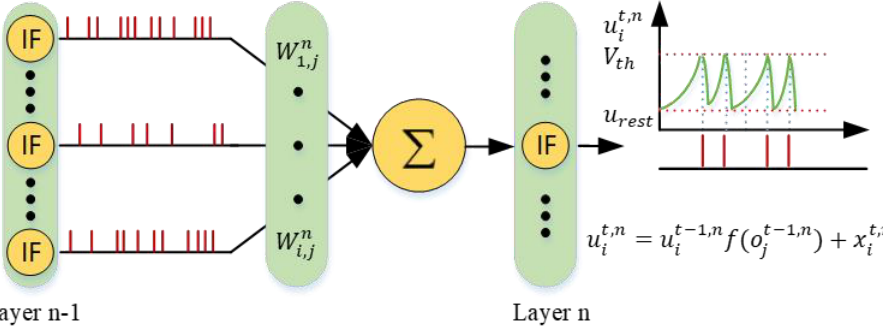
Figure 4. The update of membrane potential according to Equations (4) − (9).